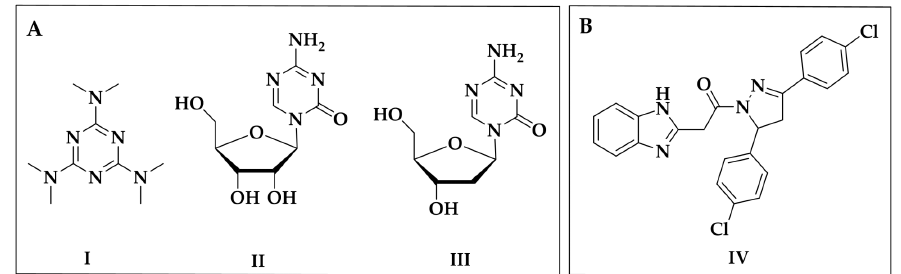
Figure 1. ( A ) Structures of some triazine-based antineoplastic drugs. ( B ) Pyrazolinic derivative with anticancer